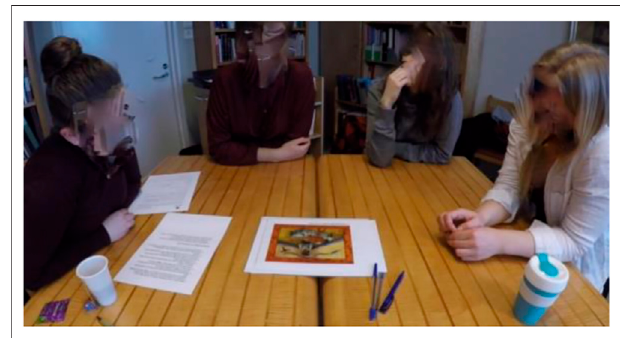
FIGURE 1 | Typical physical setting for the group